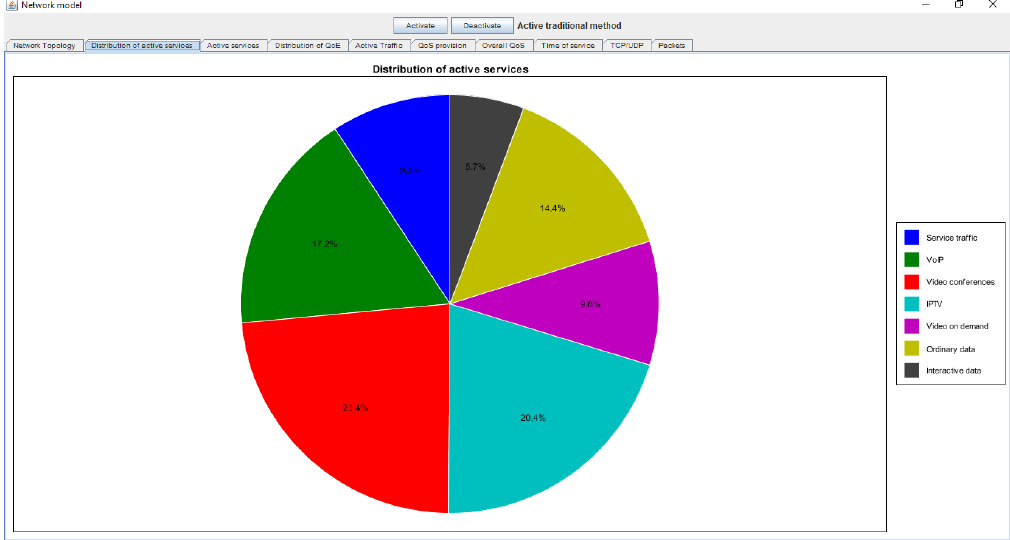
Figure 20. The active services distribution diagram.